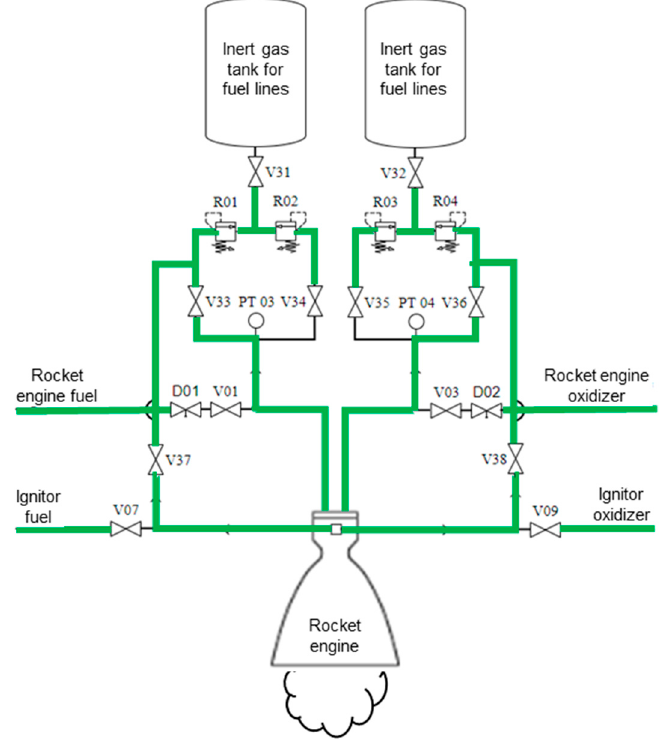
Figure 25. Algorithm’s ninth step diagram.